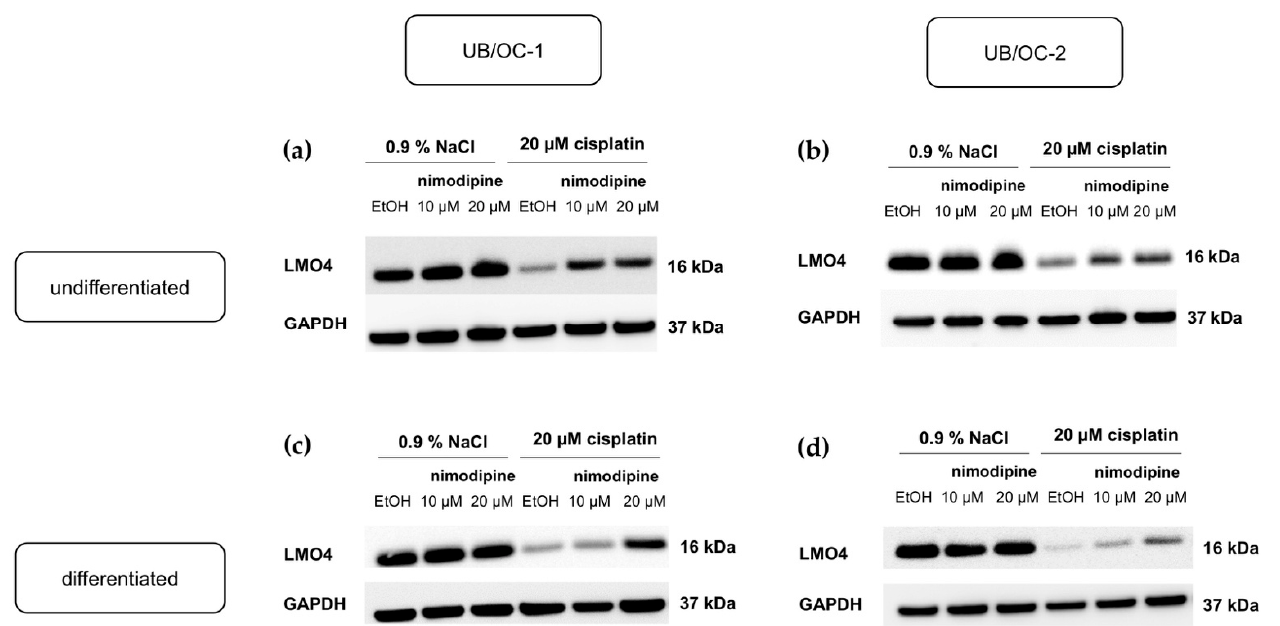
Figure 4. Analysis of the LMO4 protein amount depending on nimodipine and cisplatin treat- ment. A representative Western blot of three independent biological replicates of undifferentiated UB/OC − 1 ( a ) and UB/OC − 2 ( b ) cells as well as of differentiated UB/OC − 1 ( c ) and UB/OC − 2 ( d ) cells is shown. Fifty µg protein per sample was loaded and separated via sodium dodecyl sulfate-polyacrylamide gel electrophoresis (SDS-PAGE) and blotted onto 0.2 µ m nitrocellulose membranes as described in materials and methods section. Detection was performed by using specific antibodies.